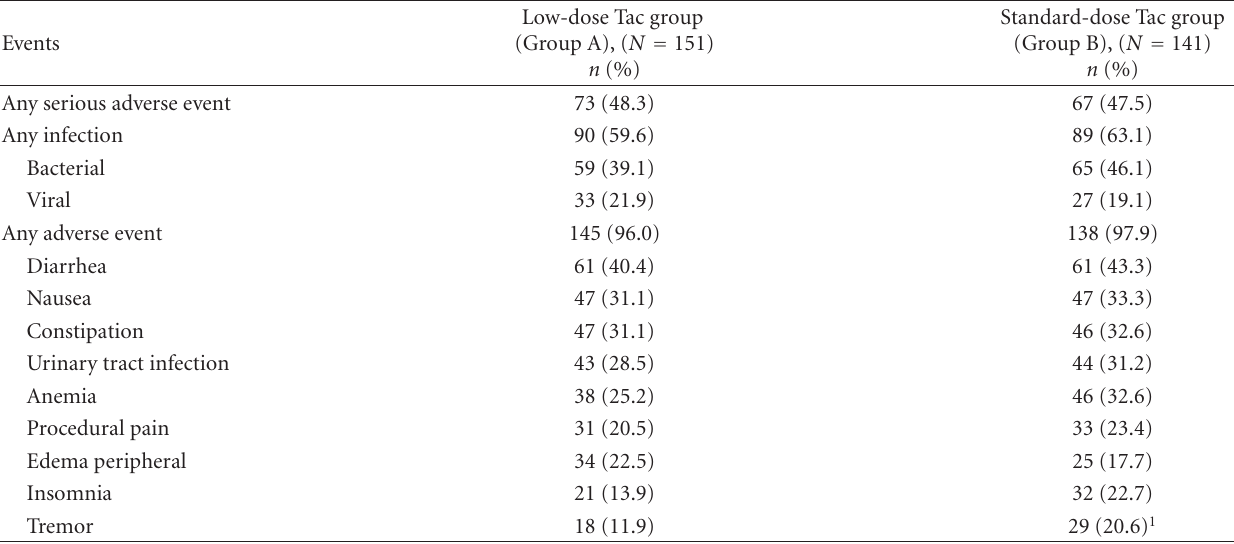
Table 3: Adverse events (AEs) occurring in ≥ 20% of patients in any group, or those AEs of particular